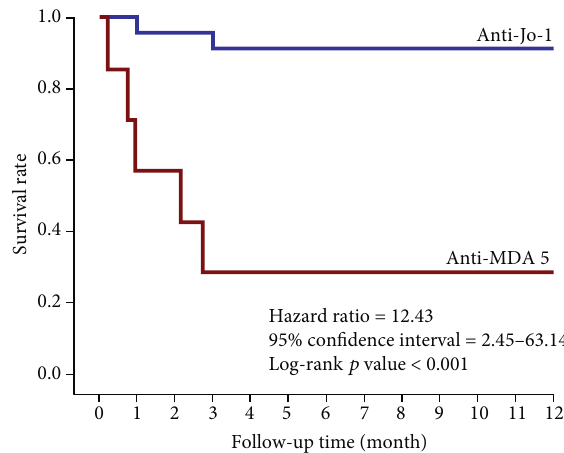
Figure 3: The Kaplan-Meier survival curve of anti-Jo-1 and anti-MDA-5